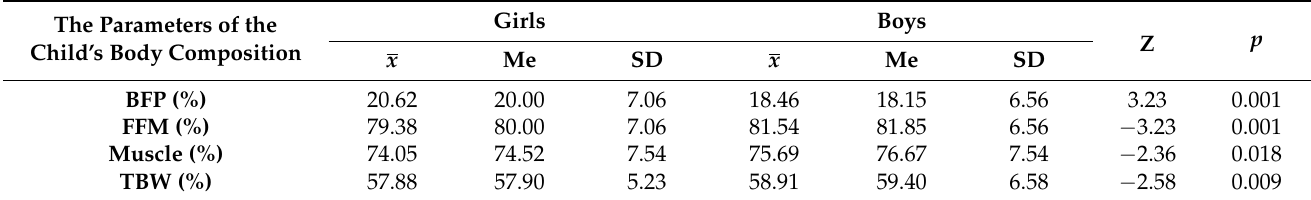
Table 3. Differences in body weight composition depending on the sex of the respondents.